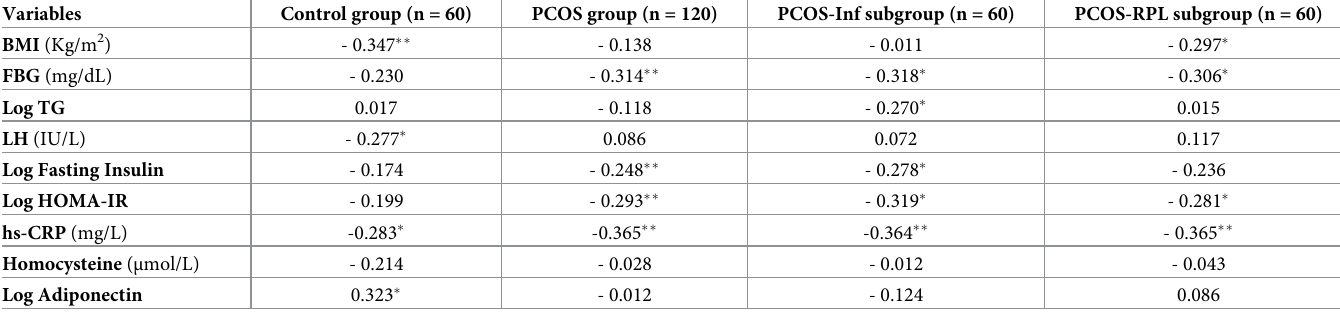
Table 3. Correlation of serum Metrnl protein with anthropometric, hormonal and biochemical